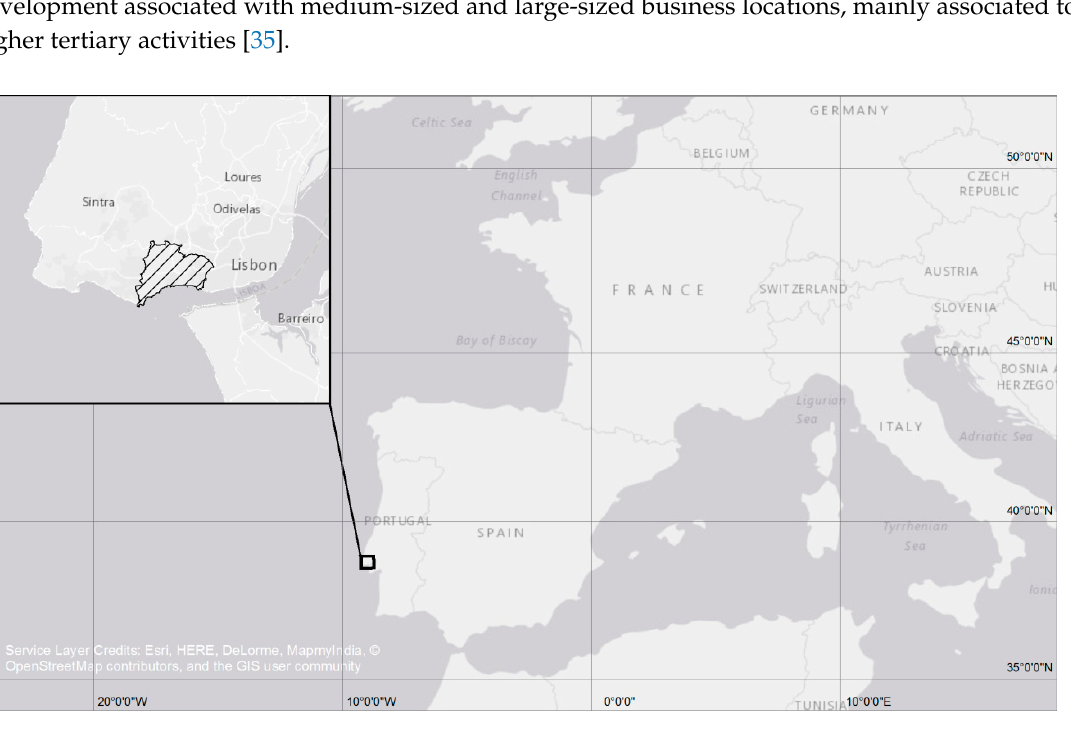
Table 2. Input data synthesis.